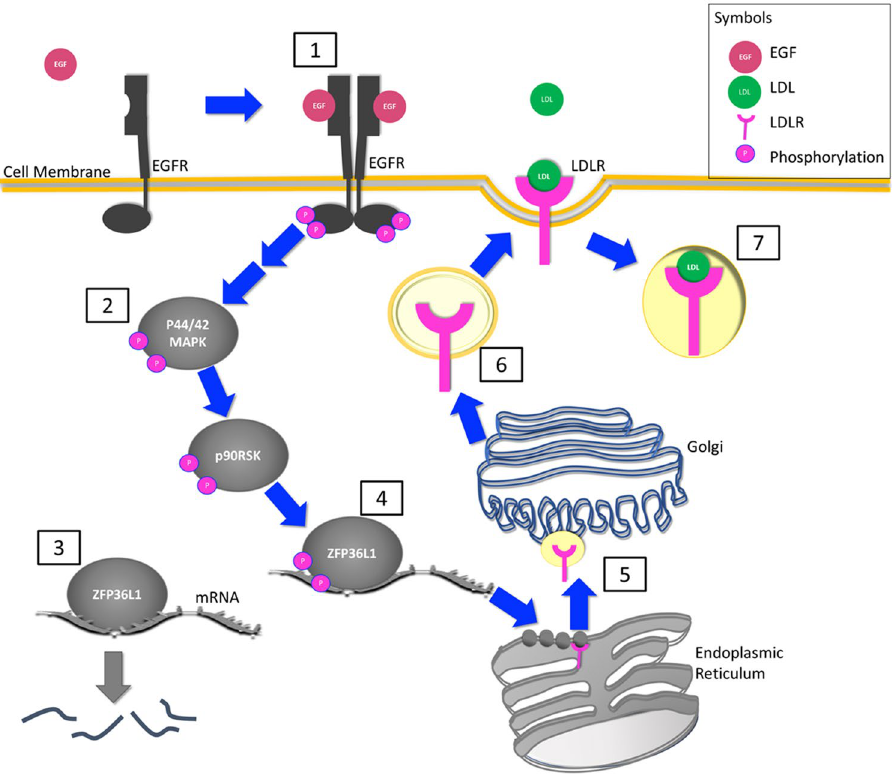
Figure 8. Schematic of proposed mechanism by which EGF stimulation leads to increased LDLR expression. (1) EGF stimulation of the EGF receptor leads to dimerization and phosphorylation of the EGFR. (2) Phosphorylation of the EGFR leads to activation of the MAPK signaling pathway (two arrows indicate intermediaries not shown in the schematic between the EGFR and p44/42 MAPK). Phosphorylation of MAPK leads to activation of p90RSK. (3) ZFP36L1 binds to AU-rich regions within the 3 ′ untranslated region of LDLR mRNA and associates with the deadenylation complex subunit, CNOT7 (not shown in schematic) 20 leading to RNA degradation. (4) Phosphorylation of ZFP36L1 prevents RNA degradation therefore increasing LDLR mRNA levels. (5) LDLR mRNA is translated by the membrane bound ribosomes of the rough endoplasmic reticulum and fully glycosylated in the Golgi. (6) The LDLRs are then transported in vesicles to the cell membrane where they are found in clathrin-coated pits. (7) LDL binds to the LDLR on the cell surface leading to internalization of the LDL/LDLR